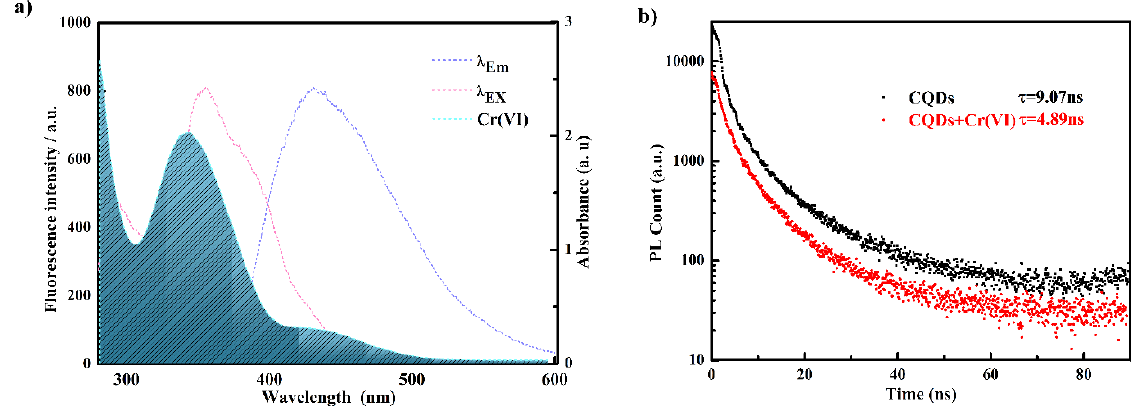
Figure 6. ( a ) The absorption spectrum of Cr(VI) and the excitation and emission spectra of Si,N-CQDs; ( b ) lifetime decays of Si,N-CQDs.